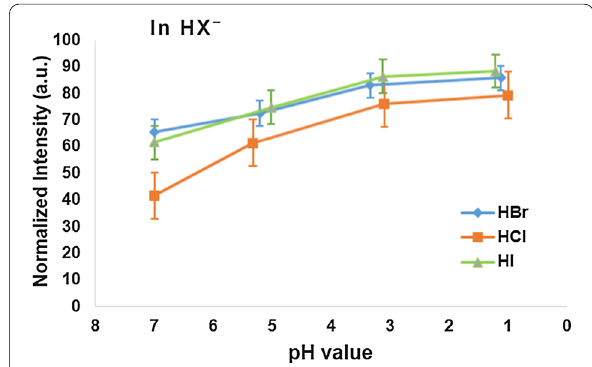
Fig. 4 The PL intensity distribution of GaN nanowires under pH variations in three hydrohalic acidic solutions